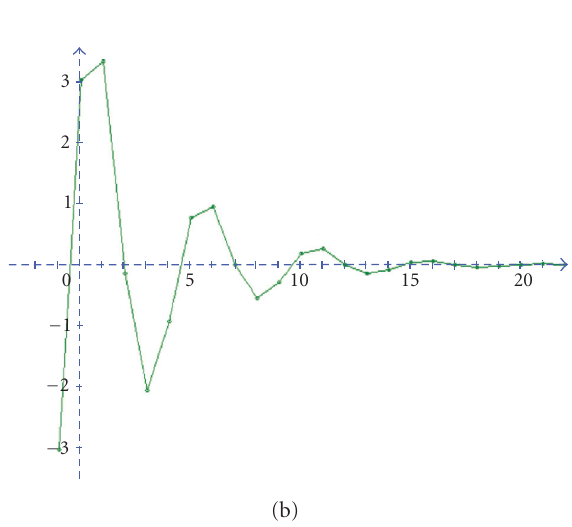
Figure 3.10. (a) Behavior of y n in the point P ; (b) behavior of x n in the point P